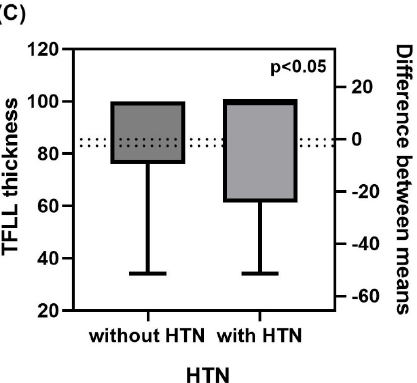
Figure 2. ( A ) SPEED scores in men and women. ( B ) SPEED scores in subjects without DM and those with DM. ( C ) TFLL thickness in subjects without HTN and those with HTN. The median value is indicated by the central horizontal line inside the box, and the lower and upper quartiles by the corresponding horizontal ends of the box. The maximum and minimum values are displayed with vertical lines connecting the points to the center box. The two dotted lines represent the mean value of each, and the distance between the lines represents the difference between the means. In Figure 2C, the median value is “100” for each. SPEED, Standard patient evaluation of eye dryness; DM, diabetic mellitus; HTN, hypertension; TFLL, tear film lipid layer.